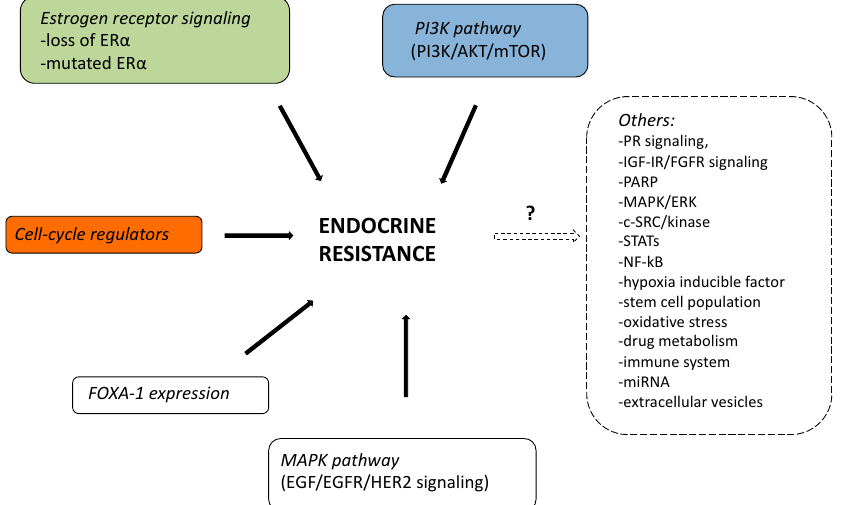
Figure 1. Possible mechanisms of endocrine resistance in summary.